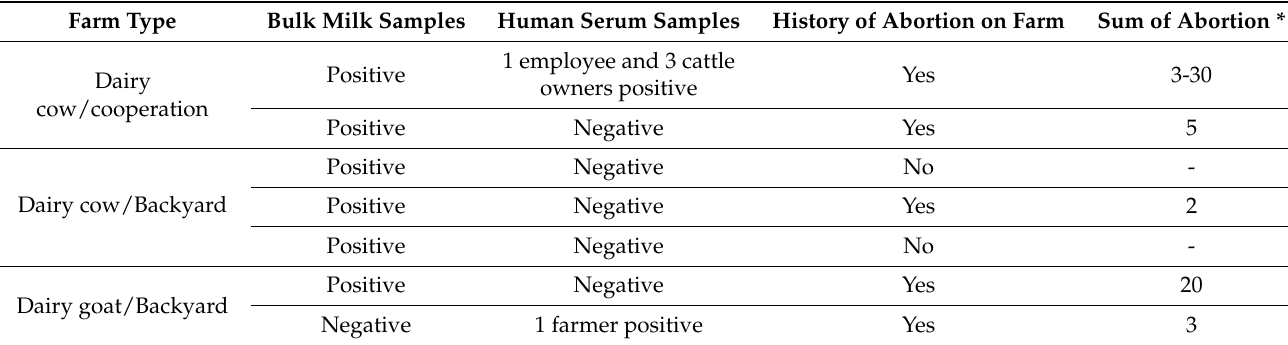
Table 5. Abortion history at farms with either seropositivity in either cattle or humans in Yiliang County, Yunnan province,